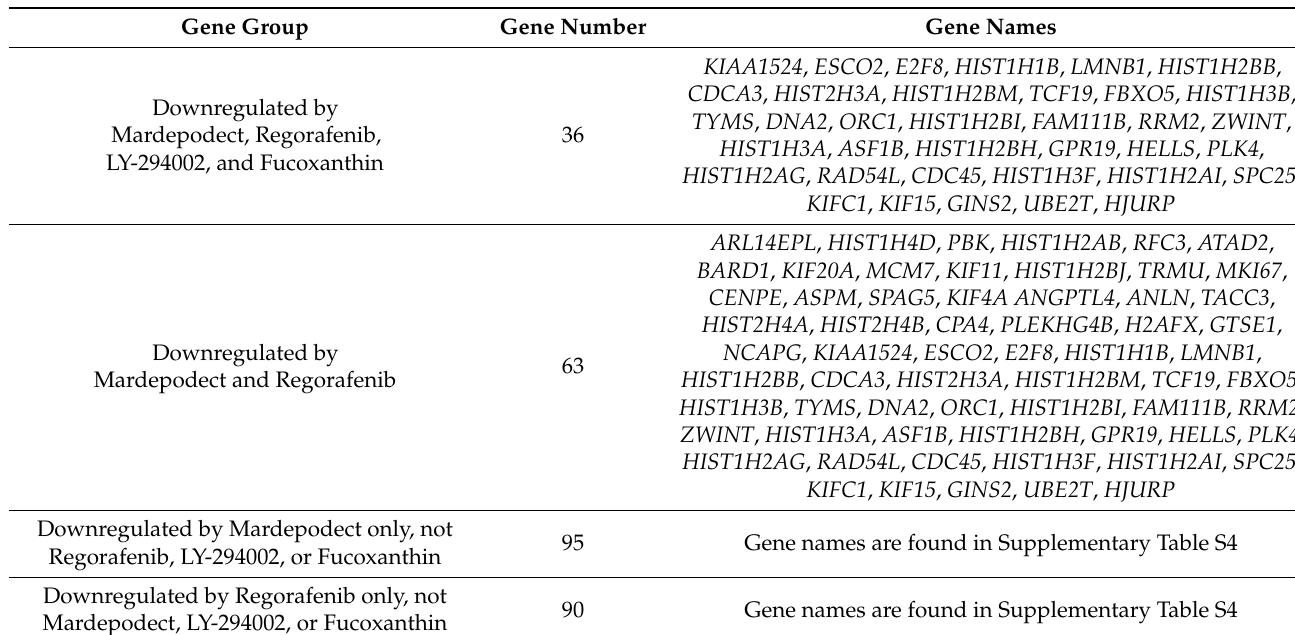
Table 2. Genes, partitioned between the drug treatments, based on sets of 200 genes with most elevated expression levels in U87MG cells (shown in Figure